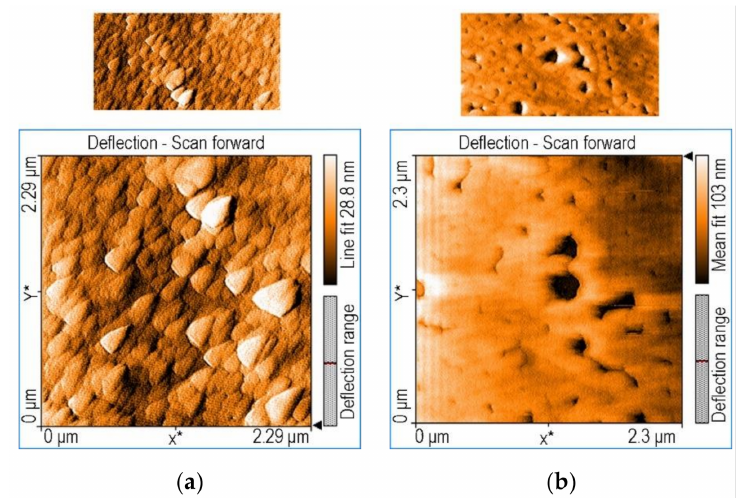
Figure 6. AFM images showing better coverage realized by trans 5,15-(4-carboxy-phenyl)-10,20- diphenylporphyrin ( a ) in comparison with cis structure, 5,10-(4-carboxy-phenyl)-15,20-(4-phenoxy- phenyl)-porphyrin ( b ).